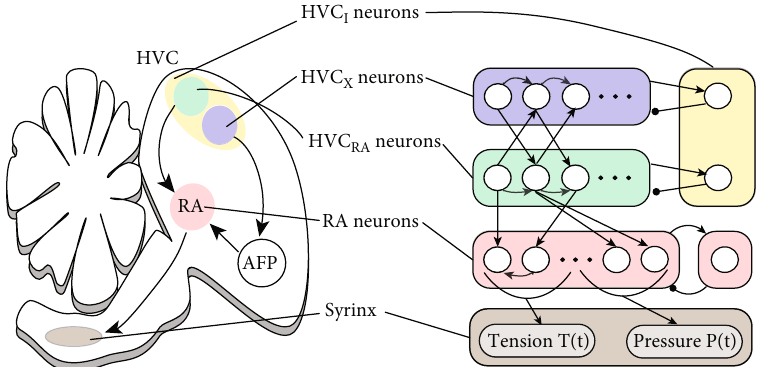
and X that project locally within the HVC. HVC and HVC act in the form of a I X RA